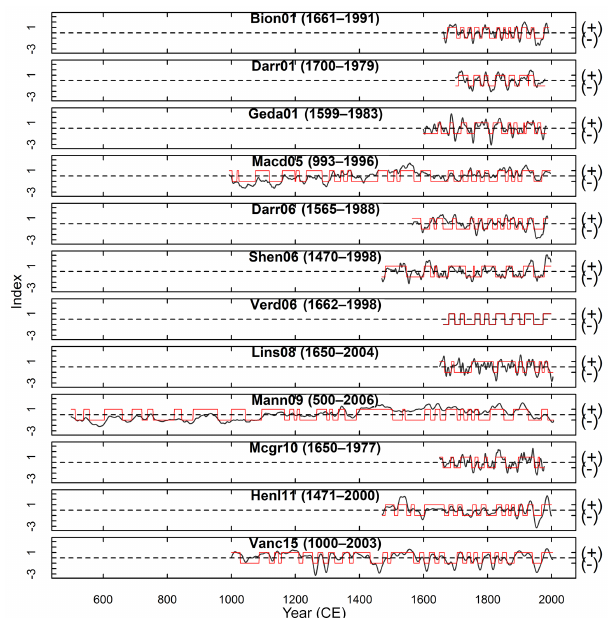
Figure 6. Density plot of run length samples by applying differ- ent window widths to all reconstructions: (a1–a3) comparison be- tween window width 20 and 40, in which (a1) is unconditional run length distribution, panel (a2) is the distribution conditioned on run lengths less than 20 years and panel (a3) is the distribution condi- tioned on run lengths greater than 20 years; (b1–b3) comparison between window width 20 and 60, in which (b1) is unconditional run length distribution, panel (b2) is the distribution conditioned on run lengths less than 30 years and panel (b3) is the distribution con- ditioned on run lengths greater than 30 years.